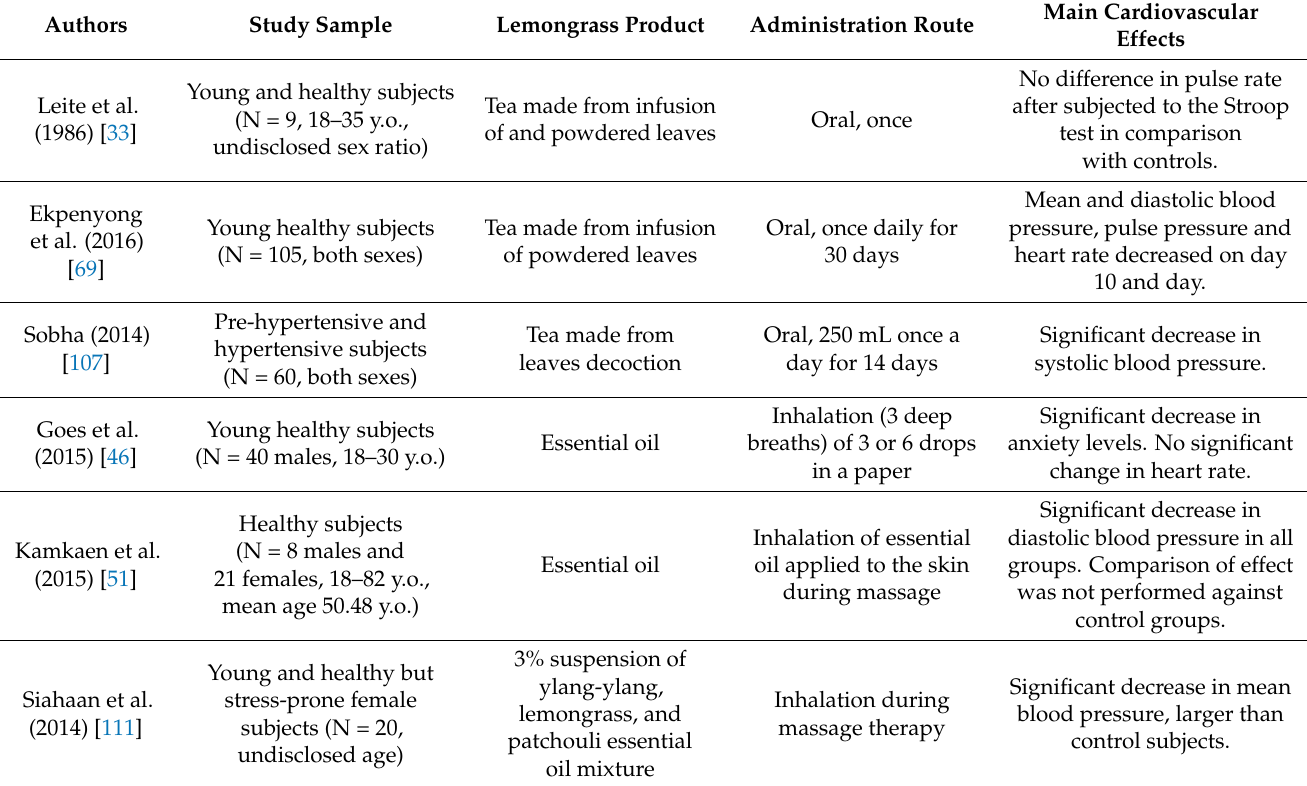
Table 6. Main cardiovascular effects of lemongrass products in human